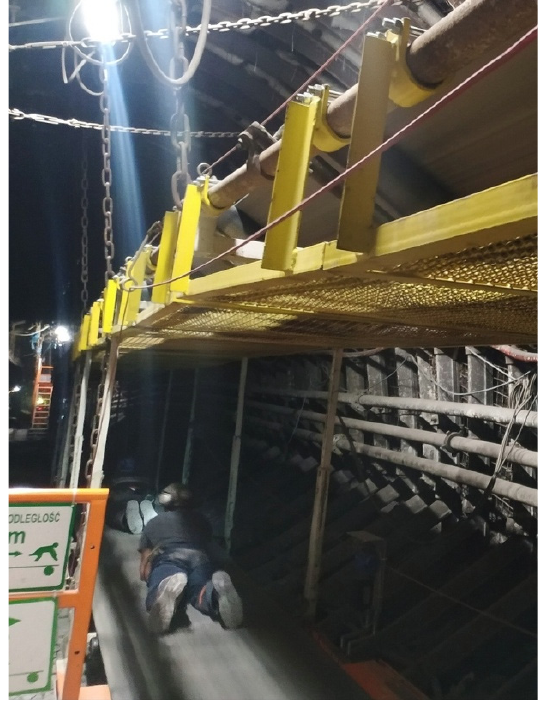
Figure 2. Crew transport system using conveyor belts ( Ł ukasz Cie ś lik, Lubelski W ę giel “Bogdanka”